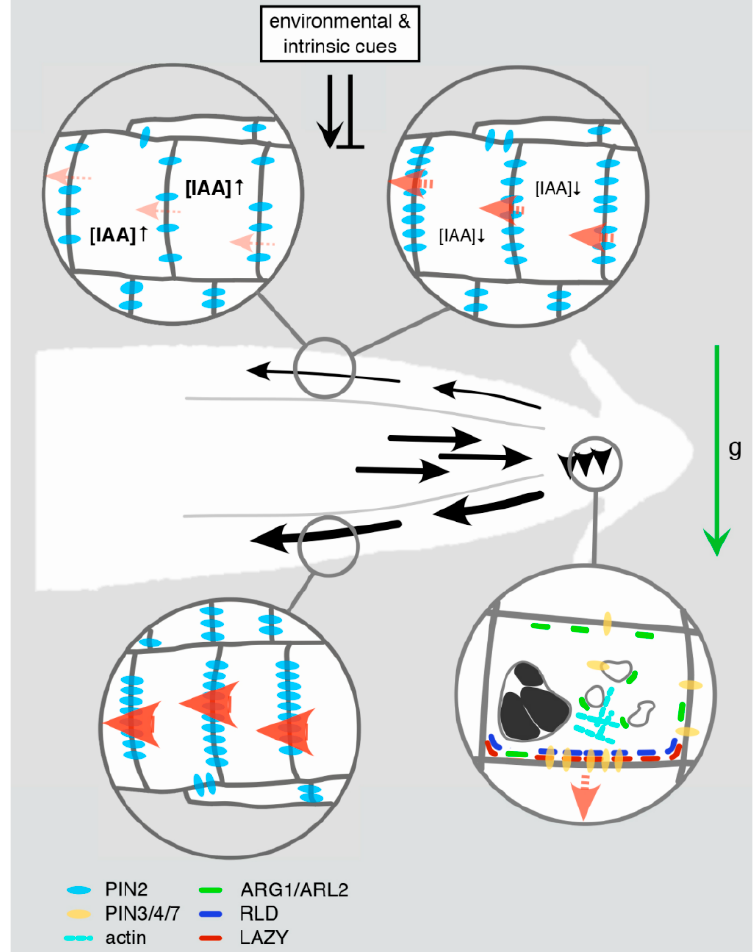
Figure 1. Gravitropic root bending and associated PIN relocation and expression. Upon gravistim- ulation (“g”, green arrow), a gradient of differential auxin fluxes is transiently established (black arrows and arrowheads), adjusting root growth direction via modulation of cell elongation. Within several minutes after gravistimulation, PIN proteins (dark yellow) in columella root cap statocytes undergo polarization at the plasma membrane at the cellular lower margin. This response appears to be triggered by starch-filled (black structures) statolith movement/sedimentation in accordance with the gravity vector. Molecular players involve ARG1/ARL2 J-domain proteins (green), which might link PIN transcytosis to vesicular transport and/or elements of the actin cytoskeleton (turquoise rods). LAZY (red) and RLD (dark blue) proteins represent another polarity determination module, whose concerted accumulation at the statocytes’ lower margin might precede polar accumulation of PINs. The resulting asymmetry in localized auxin distribution is transmitted into the root elongation zone, with elevated auxin levels transported at the root’s lower side (thick black arrows). A transient increase in the abundance of PIN2 (light blue), predominantly in epidermis cells at the lower side of the root meristem might result from diminished endocytosis and turnover of the protein. This could translate into elevated auxin flux rates (red arrowheads) in these cells, ultimately causing inhibition of cell elongation. At the root meristem’s upper side diminished levels of PIN2 are assumed to reduce auxin flux rates, promoting differential cell elongation at upper and lower and hence bending of the root. Variations in PIN2 abundance in these cells appear to be controlled by a combination of environmental and intrinsic cues, thereby impacting on intracellular auxin steady-state-levels and causing adjustments in the lateral auxin gradient. Such spatiotemporal variations in auxin flux and gradients have been suggested to participate in the resetting of differential auxin transport and gravitational root